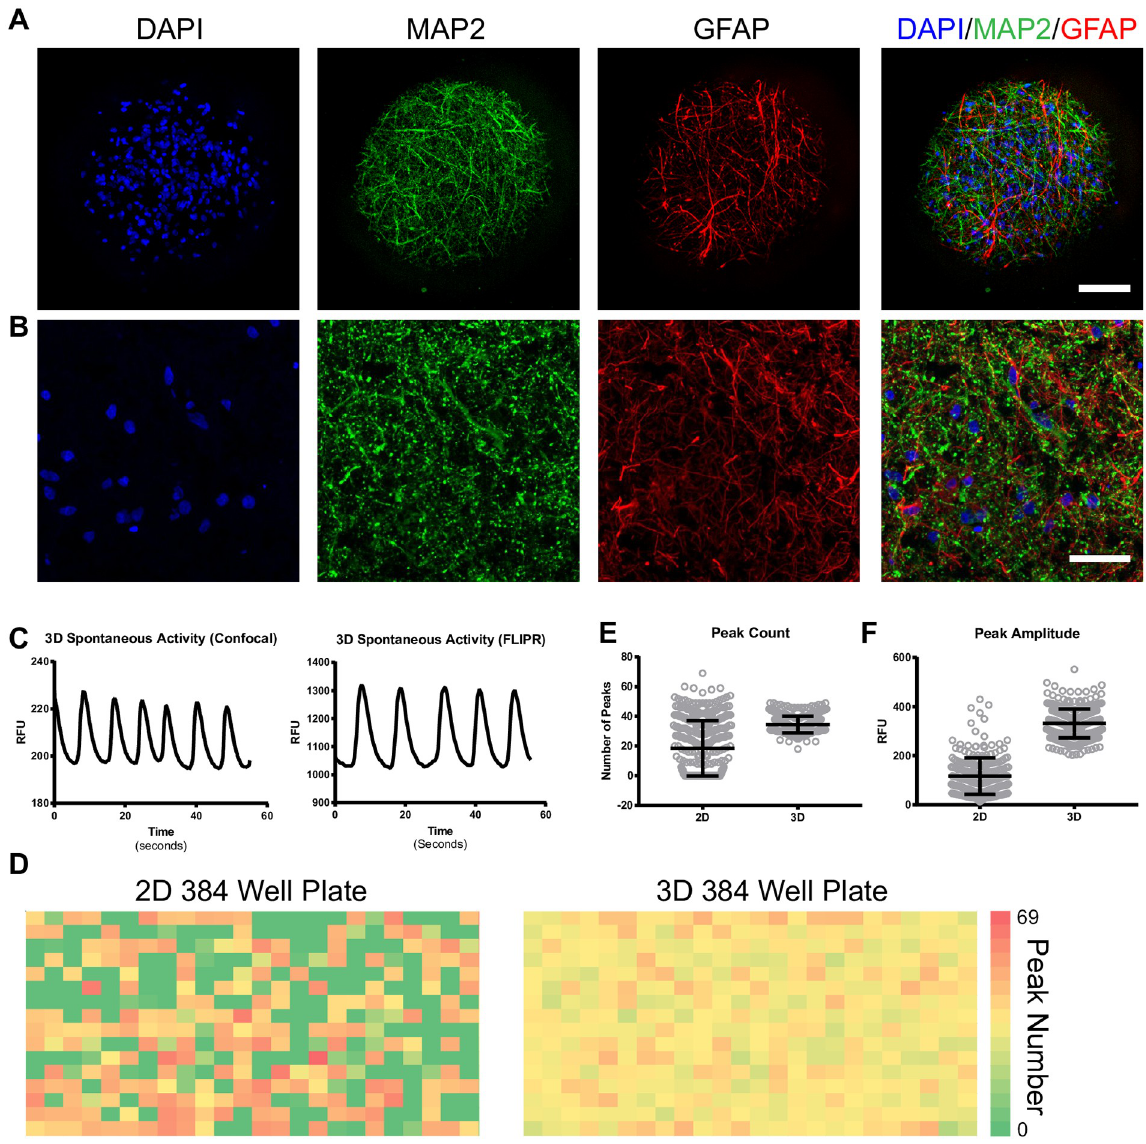
Fig 1. 3D neurospheres contain neurons and astrocytes and generate highly synchronized network activity. A) Confocal image of a 3D neurosphere showing nuclei (DAPI-blue), neurons (MAP2-green), and astrocytes (GFAP-red) demonstrating the presence of a mixture of neurons and astrocytes on the spheroid surface. B) Cryosectioned 3D sphere showing nuclei (DAPI-blue), neurons (MAP2-green) and astrocytes (GFAP-red) illustrating the presence of these cells in the interior of the spheroid. Scale bars represent 50 μ m. C) Quantification of calcium dye intensity over time in a 3D culture by confocal imaging and by FLIPR. RFU = relative fluorescence units. D) Heat map of peak frequency (peak count per 10min interval) in 384 well plate from 2D and 3D cultures. E) Mean peak count across wells of 2D and 3D plates. F) Mean peak amplitude across wells of 2D and 3D plates. Error bars represent standard